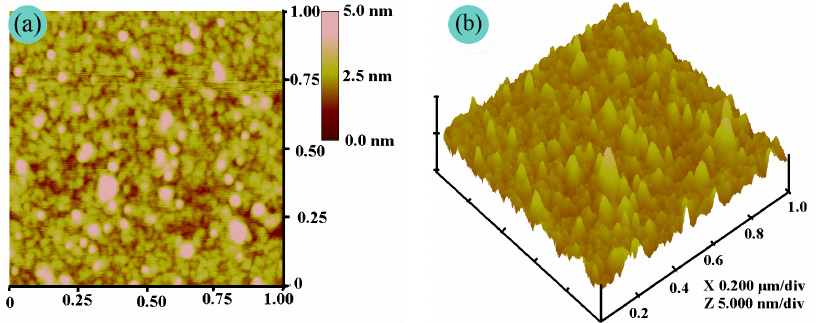
Figure 6. AFM images: ( a ) the PFAS height image and ( b ) the PFAS topography.